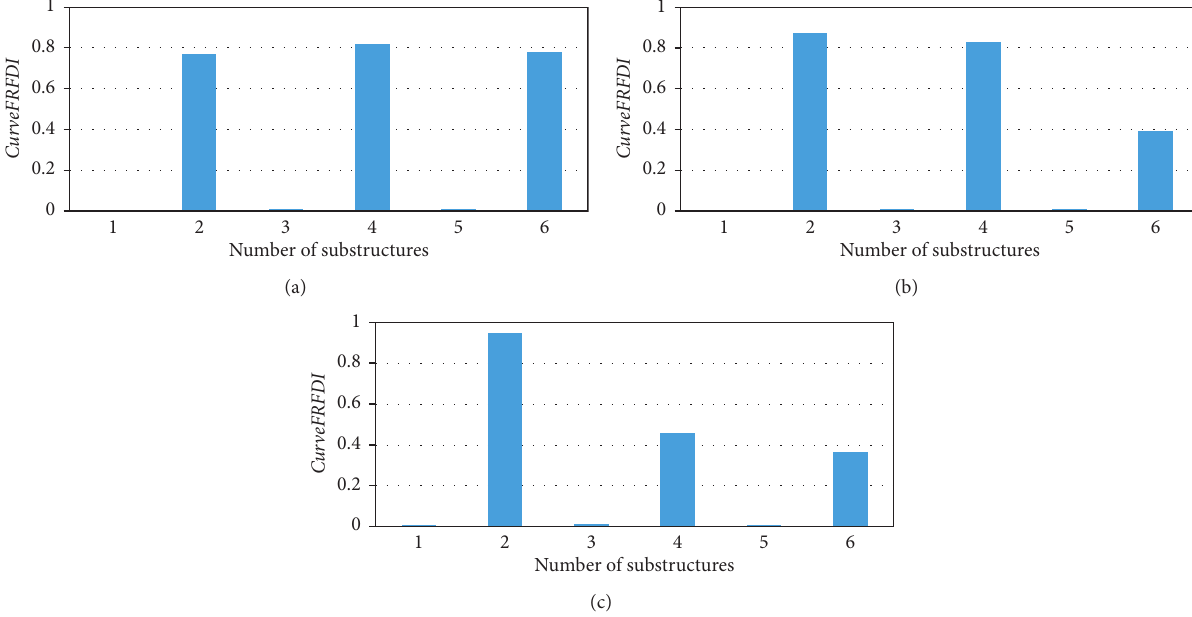
Figure 24: CurveFRFDI values for (a) case Dam_2F5%&4F15%&6F10%, (b) case Dam_2F10%&4F15%&6F5%, and (c) case Dam_2F15%